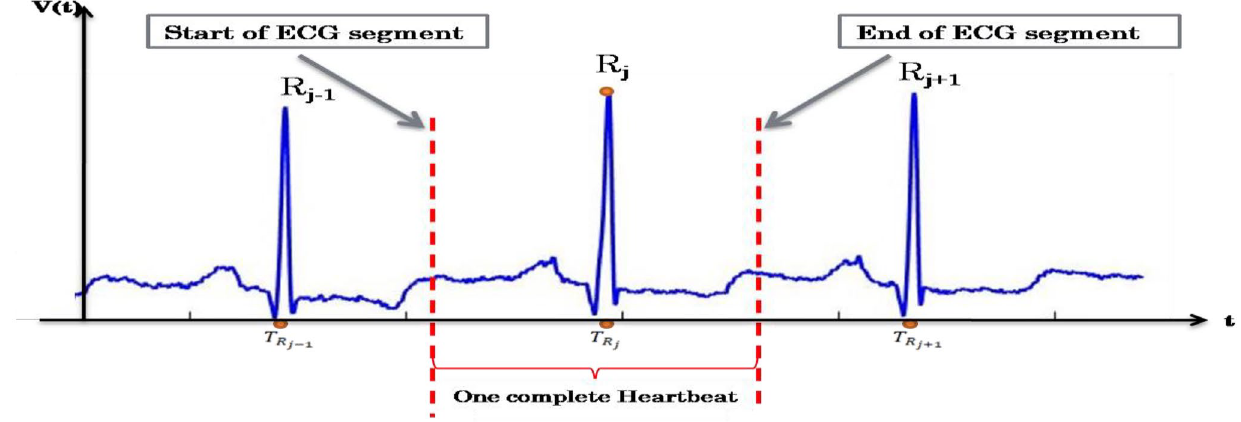
Fig. 3 An illustration for the heartbeat segmentation